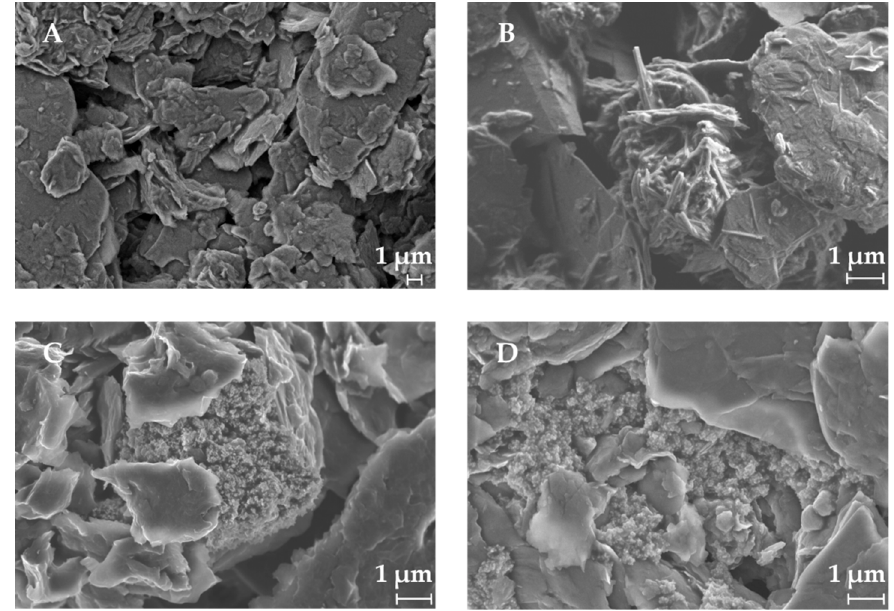
Figure 5. Scanning Electron Microscopy (SEM) characterization of ( A ) Graphite/SPCE-Ink, ( B ) Cobalt (II) phthalocyanine/SPCE-Ink, ( C ) Copper oxide (II)/SPCE-Ink and ( D ) Prussian blue/SPCE-Ink.